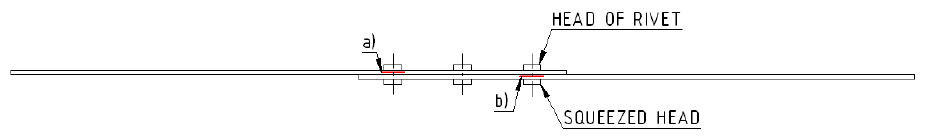
Figure 6. Crack locations in the specimen.